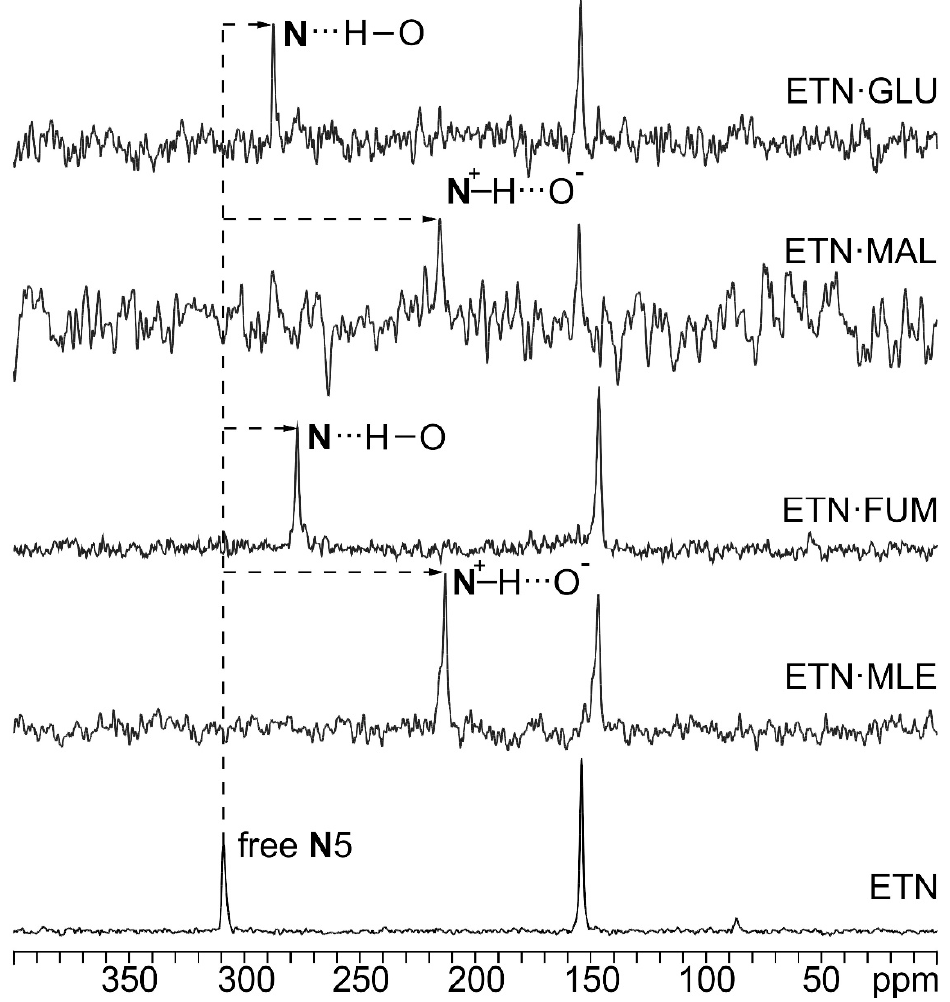
Figure 9. 15 N CPMAS spectra of the analyzed compounds. Dashed lines highlight the chemical shift of N5 in pure ETN. Table 3. 13 C and 15 N SSNMR chemical shift values for all analyzed powders. The atom numbering is referred to as Scheme 1.